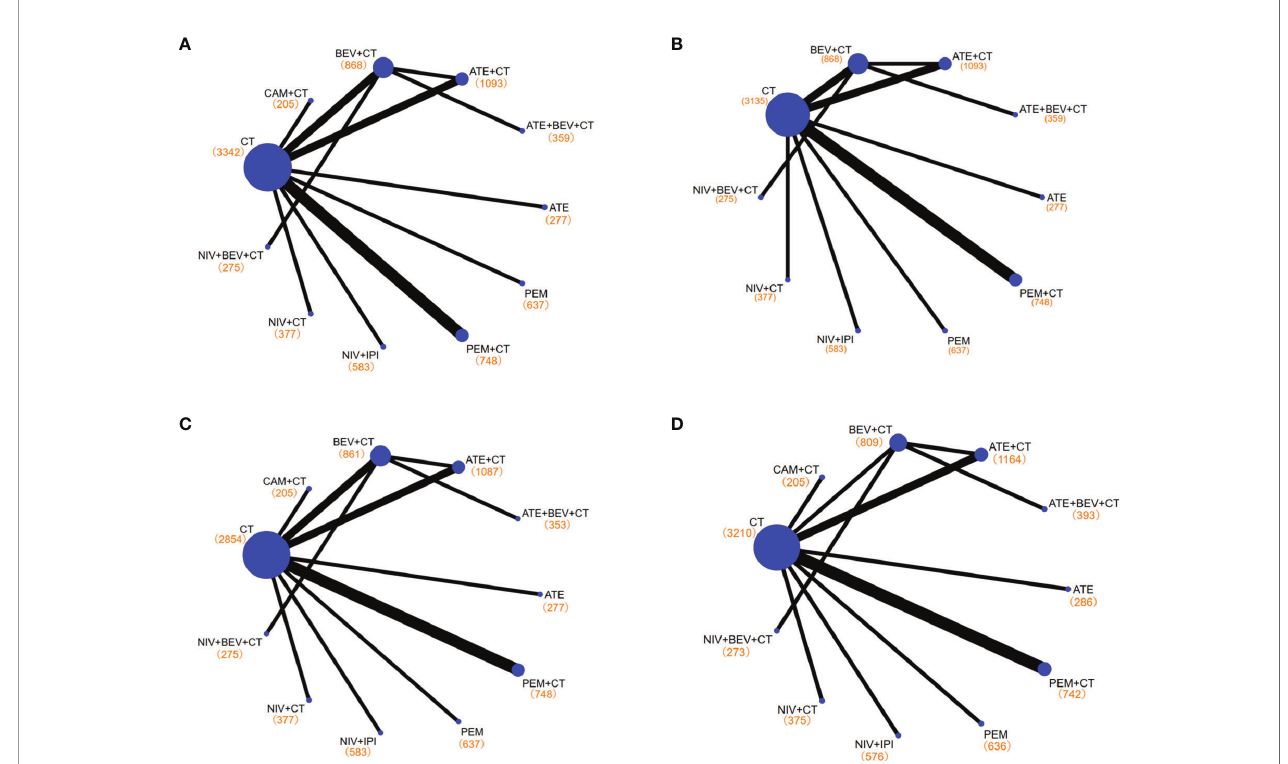
FIGURE 3 | Network diagrams of comparisons on different outcomes of treatments with long-term survival time in patients with advanced wild-type non-small cell lung cancer. (A) Comparisons on overall survival (OS) and progression-free survival (PFS) and 1-year survival rate and 1-year PFS rate. (B) Comparisons on 2-year survival rate. (C) Comparisons on objective response rate (ORR). (D) Comparisons on adverse events of grade 3 or higher ( ≥ 3 AEs). Each circular node represents a type of treatment. Each line represents a type of head-to-head comparison. The size of the nodes and the thickness of the lines are weighted according to the number of studies evaluating each treatment and direct comparison, respectively. The total number of patients receiving a treatment is shown in brackets. PEM, pembrolizumab; ATE, atezolizumab; NIV, nivolumab; CAM, camrelizumab; BEV, bevacizumab; CEM, cemiplimab; CT,